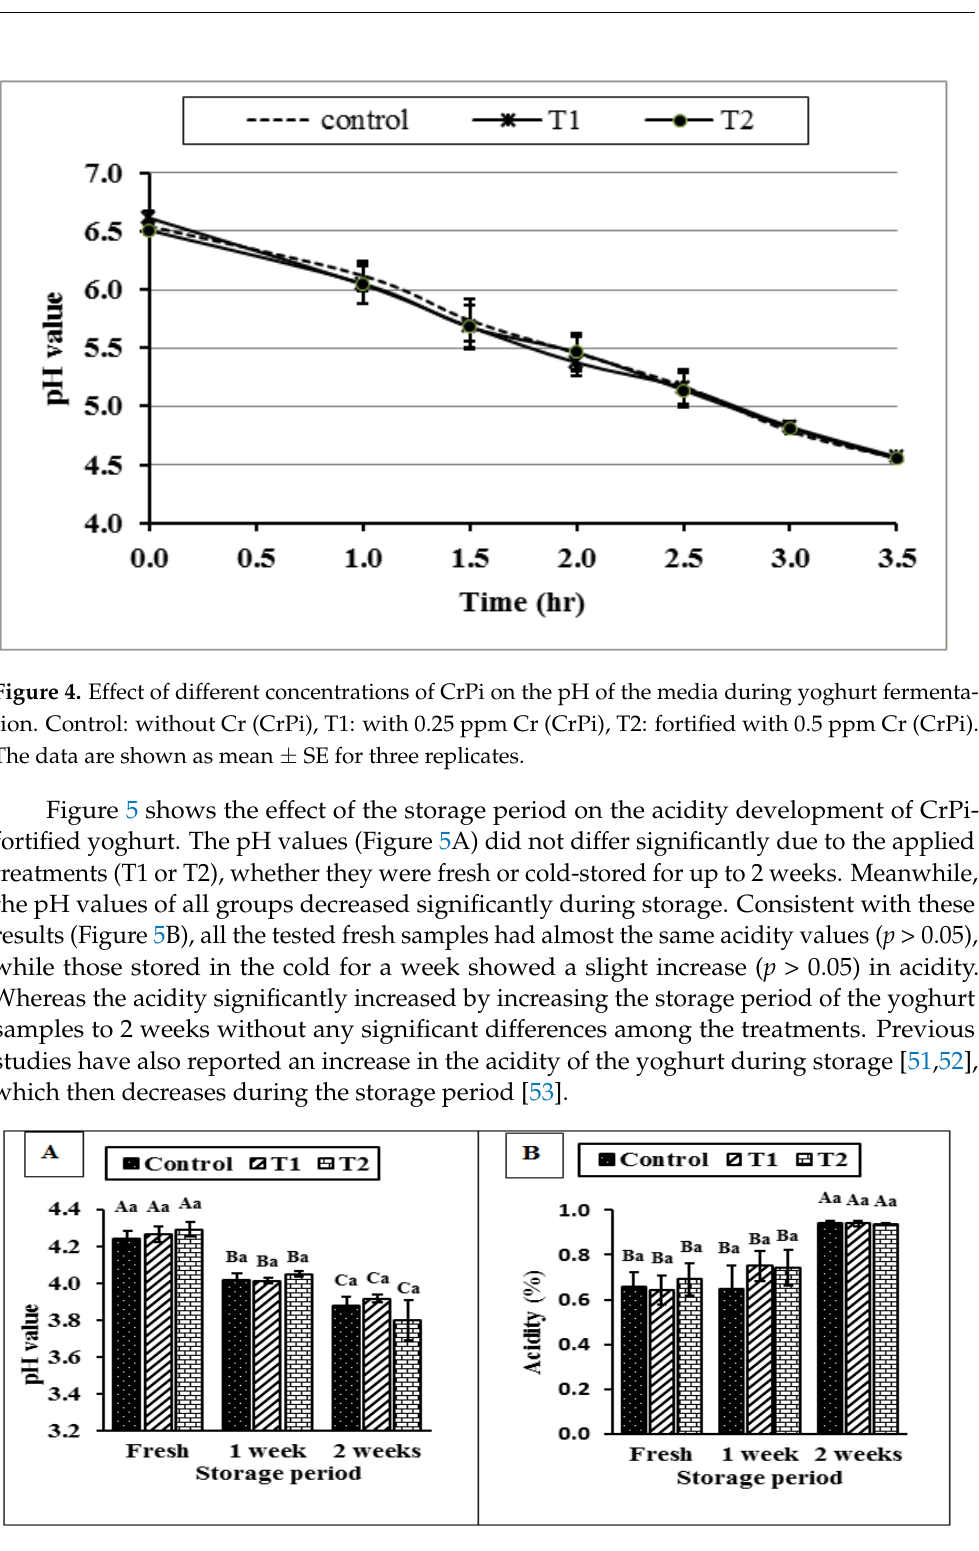
Figure 5. Effect of different concentrations of chromium (CrPi) on the pH ( A ) and acidity ( B ) of yoghurt during storage. Control without Cr (CrPi), T1 with 0.25 ppm Cr (CrPi), T2 fortified with 0.5 ppm Cr (CrPi). Data are shown as mean ± SE for three replicates. Means with different small letters are significantly different between the treatments ( p ≤ 0.05). Means with different capital letters are significantly different between the storage periods ( p ≤